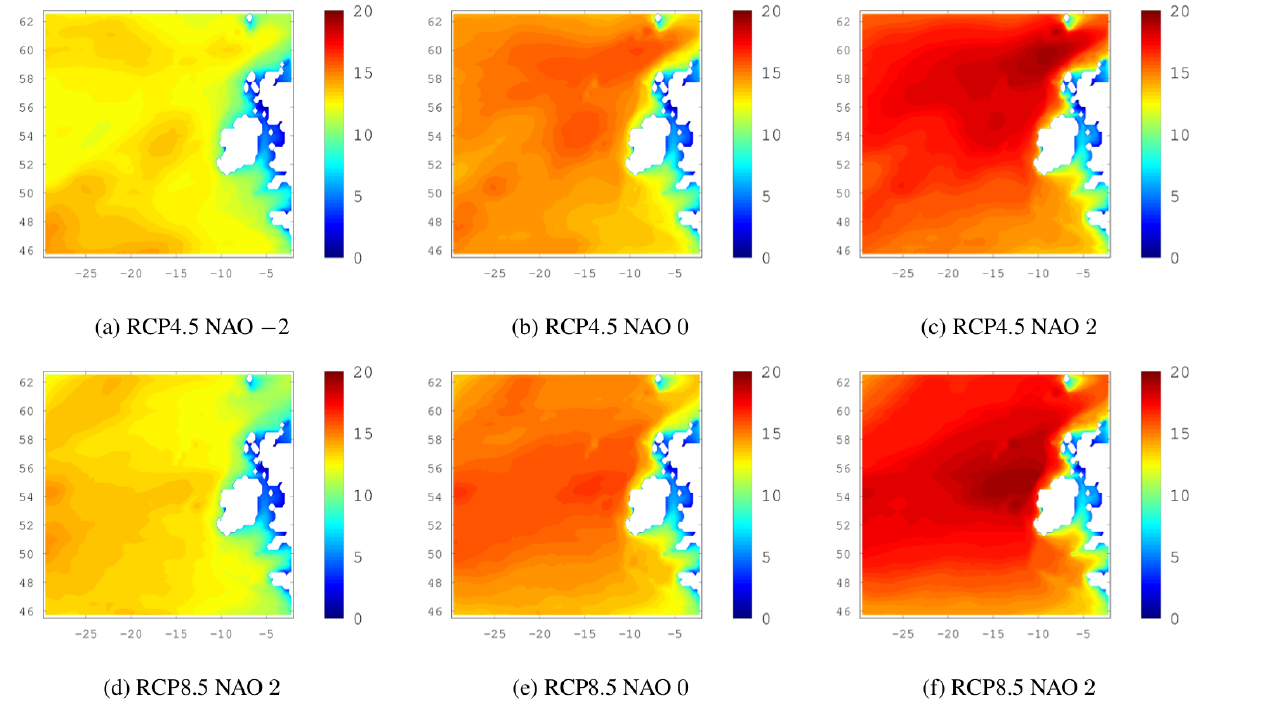
Figure C1. 20-year return levels of H s . The NAO index varies from 3 values of the NAO index while the EA and SCAND are held in their neutral state (zero). The top row shows the ensemble mean for the future period under RCP4.5 and the bottom row is similar but shows RCP8.5